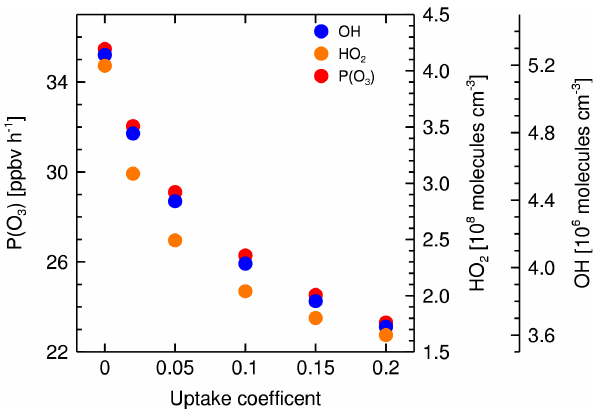
Fig. 8. Daytime average HO 2 , OH and P(O 3 ) as a function of γ (HO 2